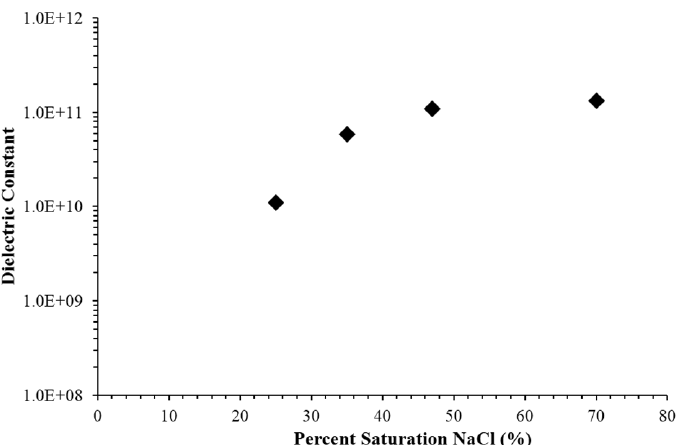
Table 1. Capacitors tested with Galvanostat.